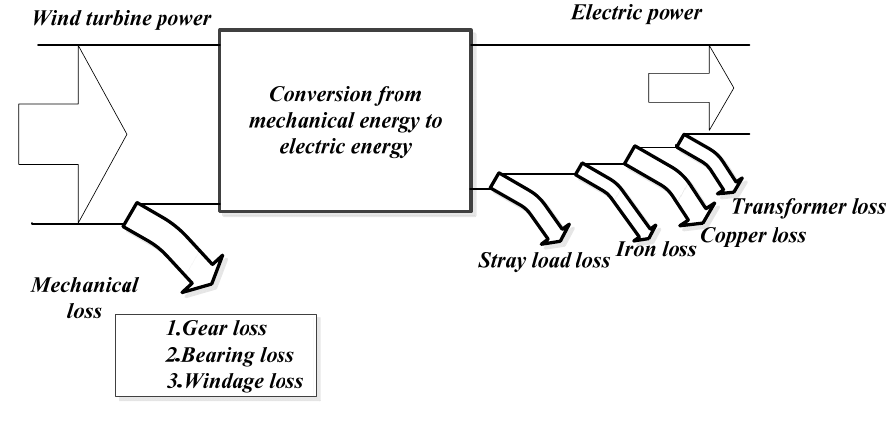
Figure 1. WT system power